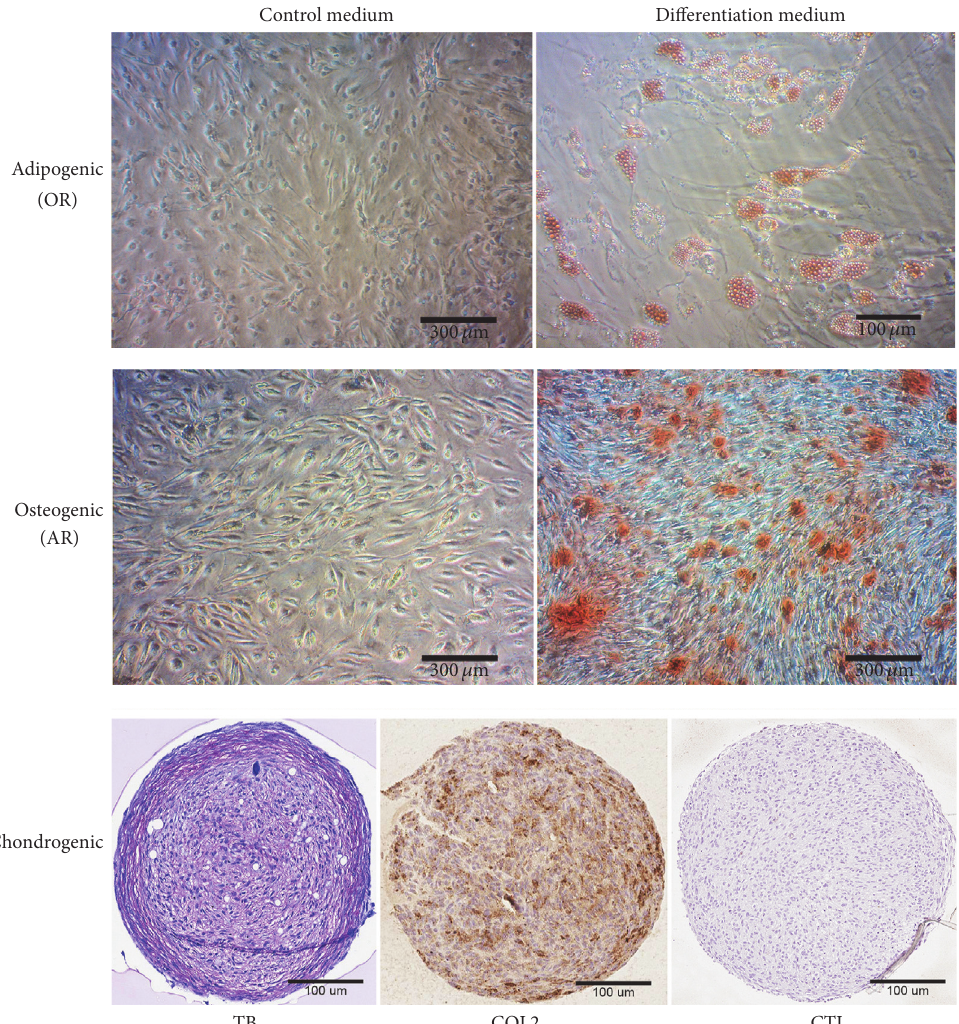
Figure 3: Differentiation assay. In vitro differentiation assay of synovial fluid isolated cells to the mesenchymal lineages, adipocytes, osteoblasts, and chondrocytes. Control medium was expansion medium. Adipogenic differentiation was visualized by Oil Red (OR) staining. Osteogenic differentiation was visualized with Alizarin Red (AR) staining. Chondrogenic differentiation was visualized with Toluidine Blue (TB) staining and COL2 and immunohistochemistry using a monoclonal antibody directed to type II collagen. CTL, no primary antibody was